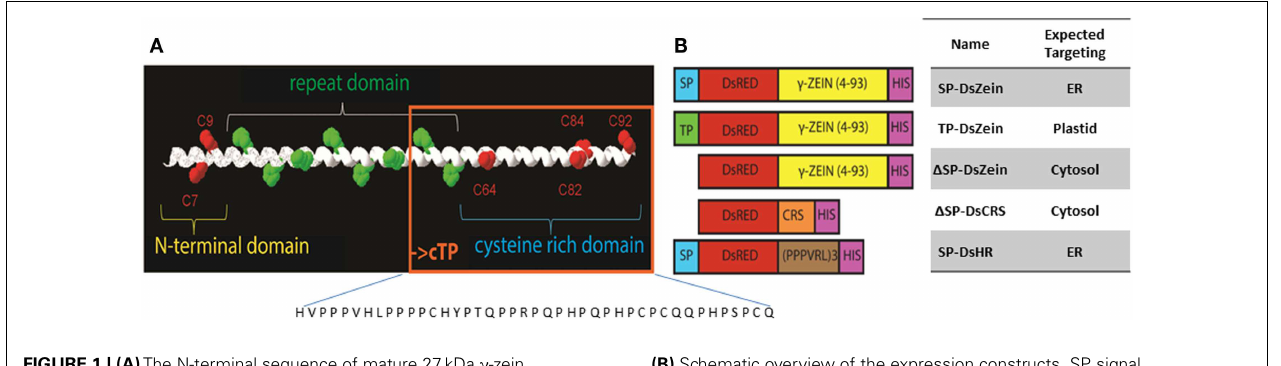
(B) Schematic overview of the expression constructs. SP, signal peptide for entry into the ER;TP, plastid-targeting peptide; DsZein, fluorescent marker protein plus γ -zein(4–93); CRS, cysteine-rich sequence (residues 51–93); HR, hydrophobic repeat sequence (PPPVRL) 3 ; HIS, polyhistidine